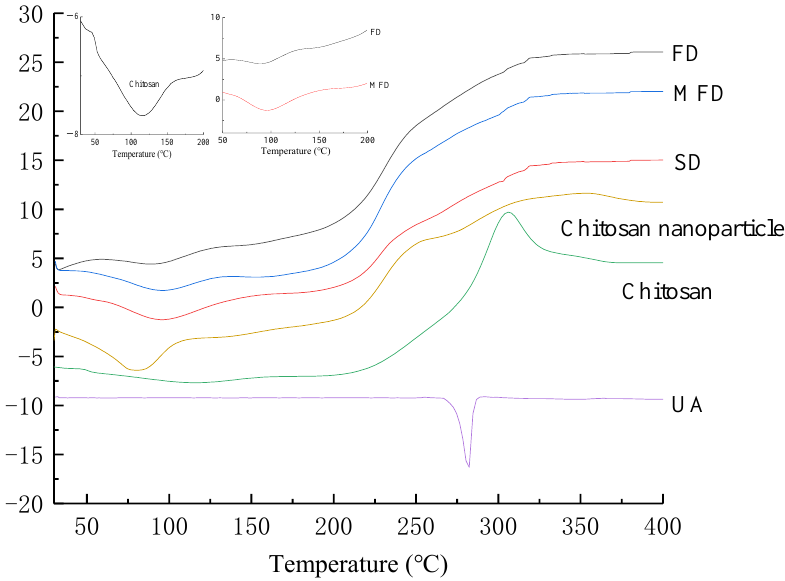
Figure 3. DSC spectra of chitosan, UA, freeze-, microwave freeze- and spray-dried, UA-loaded chitosan nanoparticles. UA-loaded chitosan nanoparticles prepared by freeze drying (FD), microwave freeze drying (MFD) and spray drying (SD). UA: ursolic acid.